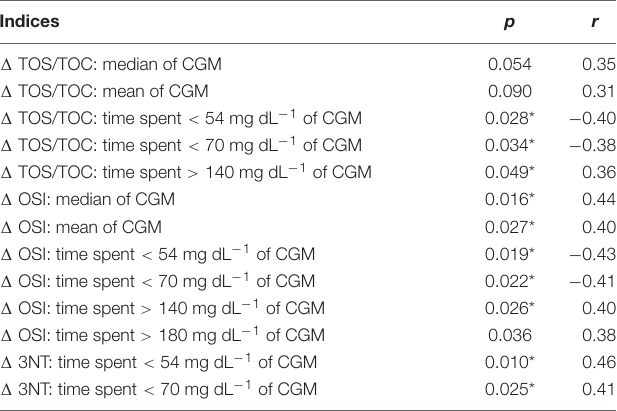
TABLE 6 | Pearson correlation